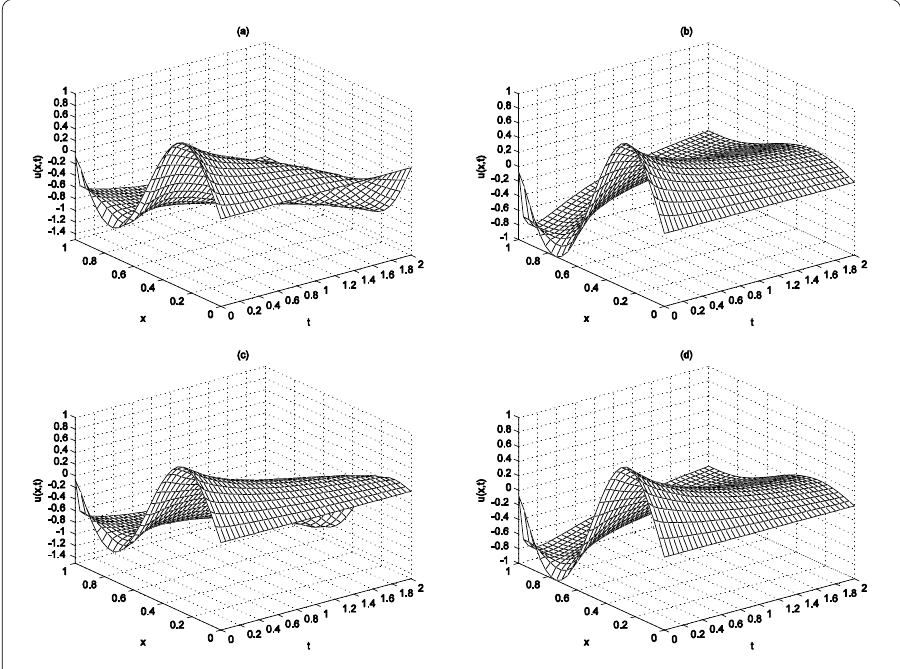
Figure 16 A 3-d landscape of the dynamics of the MGKdVB equation without control; v = 0.01, μ = 0.001, γ 1 = 1, γ 2 = 0.0005 and u 0 ( x ) = sin(2 π x ); ( a ) α = 1; ( b ) α = 2; ( c ) α = 3; ( d ) α = 4